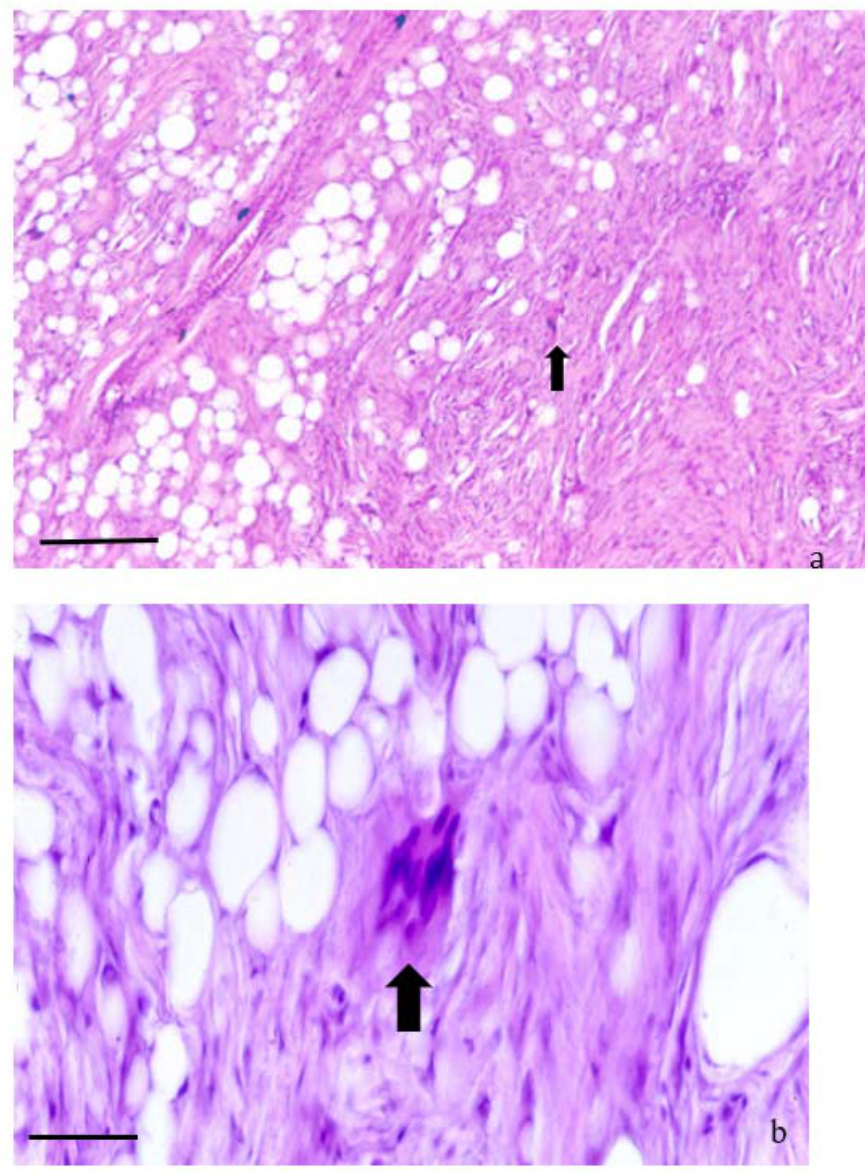
Figure 5. ( a , b ). ATYPICAL SPINDLE CELL-LIKE LIPOMA (ASCL). ( a , b ). Histological section of an atypical spindle cell-like lipoma. These neoplasms display a prevalent aspect of spindle cell lipoma, for the abundance of spindle-shaped and fibroblastic components. The structure consists of poorly defined whorls and interlacing bundles of fibroblasts ( b ) H&E (bar = 100 µ m). ( b ) Higher magnification of the ( a ). The image shows a mixture of adipocytes and uniform spindle cells. These are associated with bundles of collagen. These tumors differ from the spindle-shaped lipoma due to the presence of scattered bizarre multinucleated giant cells (black arrow) H&E (bar = 50 µ